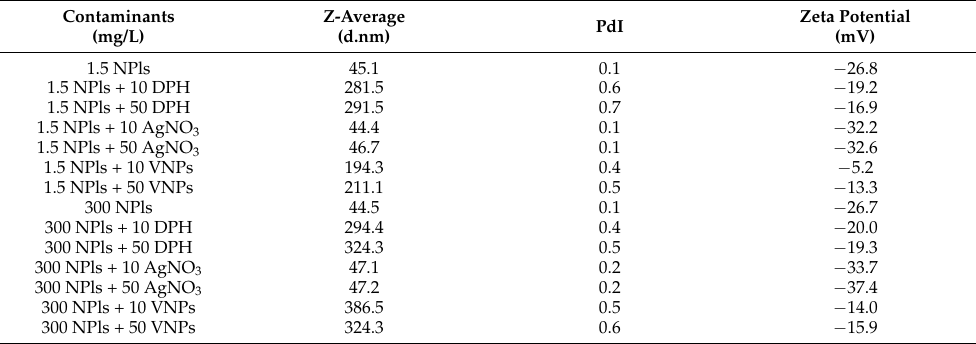
Table 1. Characterization of the test dispersions: single exposures of polystyrene nanoplastics (NPls) (1.5 and 300 mg/kg) and their combinations with diphenhydramine (DPH), silver nitrate (AgNO3) and vanadium nanoparticles (VNPs). Z-average—Hydrodynamic diameter; PdI—polydispersity index. Contaminants